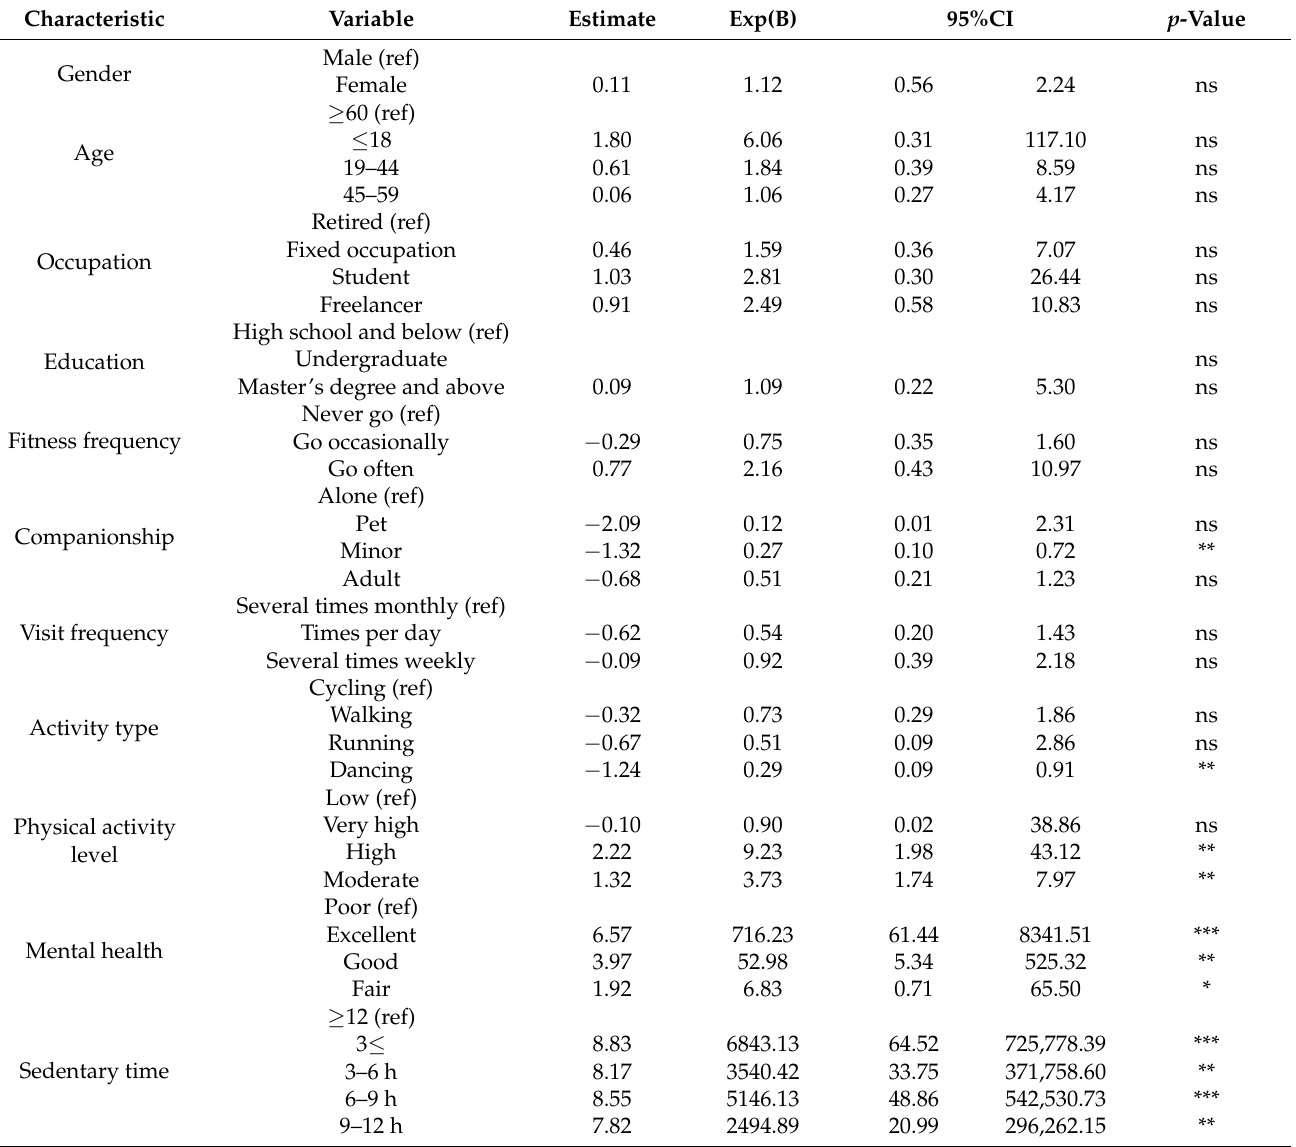
Table 7. Orderly logistic regression analysis of influencing factors of physical